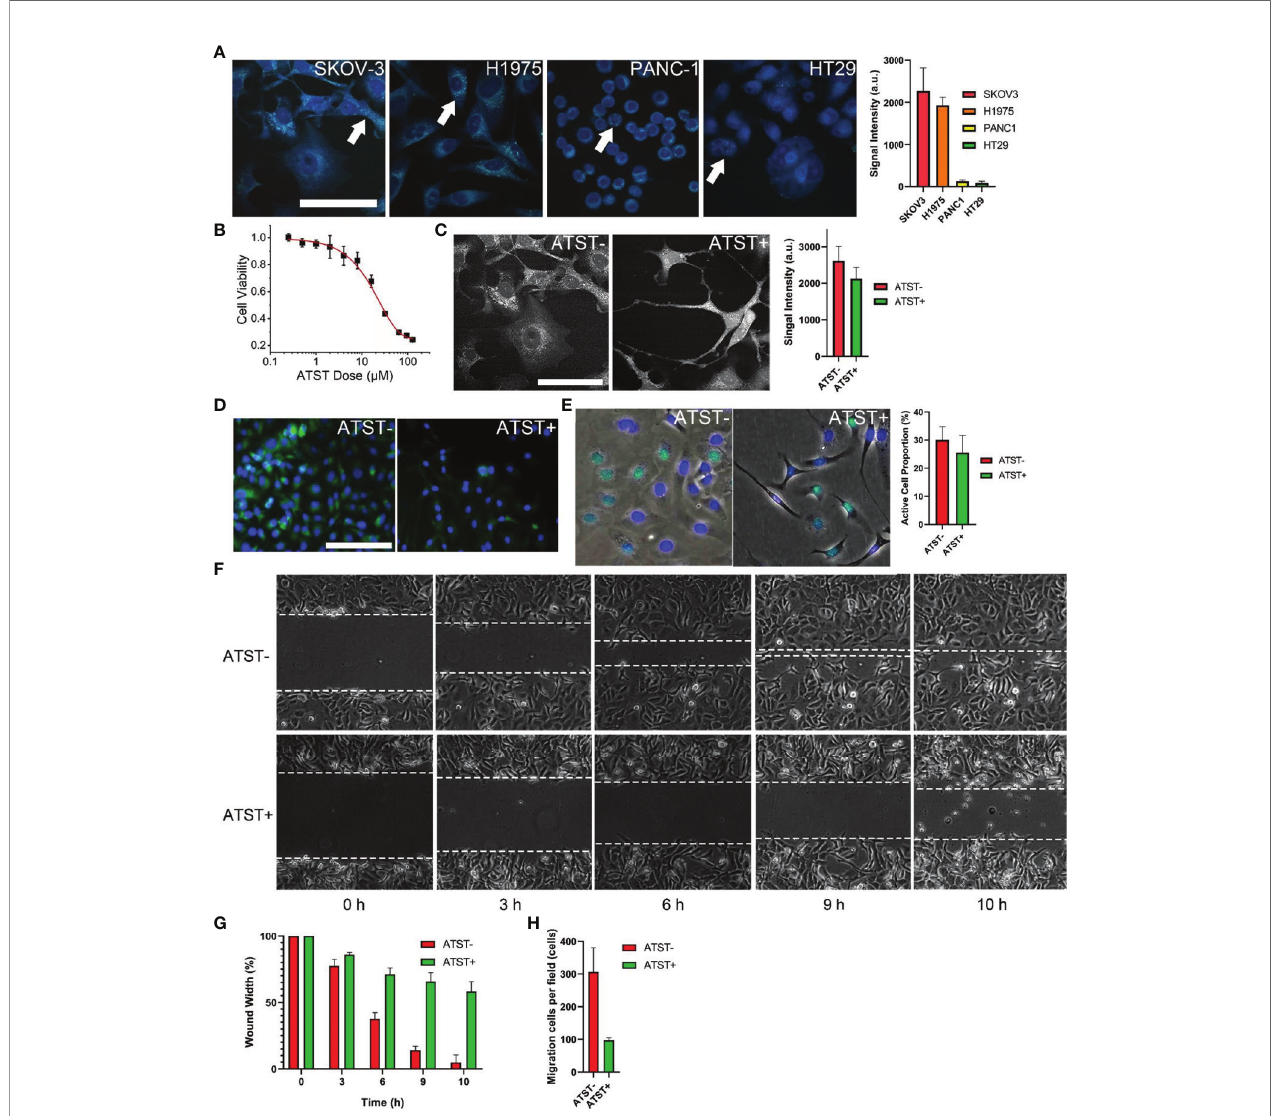
FIGURE 1 | Cell characterization (A) Lipid droplets (LD) in four cell lines and quanti fi ed signal intensity (scale bar is 10 µm, pseudo color generated by ImageJ). Arrows indicate LDs in cytosol. (B) IC 50 of atorvastatin (ATST) for SKOV-3 cells. (C) SKOV-3 LDs under SRS microscopy and quanti fi ed signal intensity (scale bar is 10 µm). (D) Fluorescence imaging of dye-stained LDs in SKOV-3 cells (scale bar is 100 µm, PKH67: green; DAPI: blue). (E) EdU image of SKOV-3 cells (EdU: green; DAPI: blue). (F) Representative image of wound healing assay (n=3). (G) Quanti fi cation of in vitro wound healing assay. (H) Quanti fi cation analysis of trans-well migration